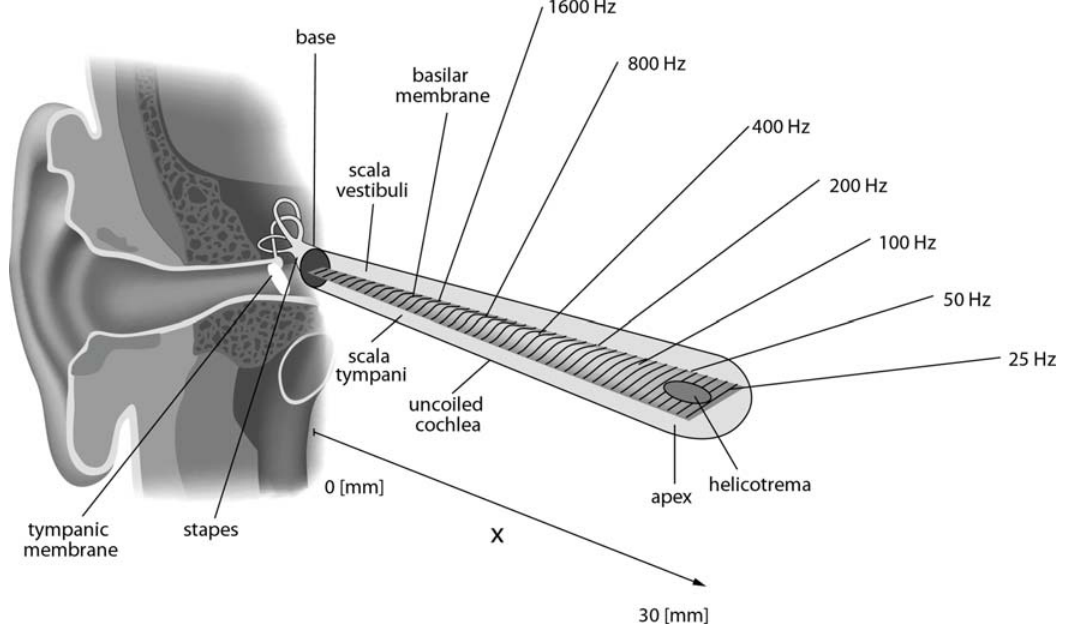
Figure 2. Uncoiled cochlea with BM. The position x of the maximal amplitude of the travelling wave corresponds in a 1-to-1 way to a stimulus frequency. (Adapted from [26].)